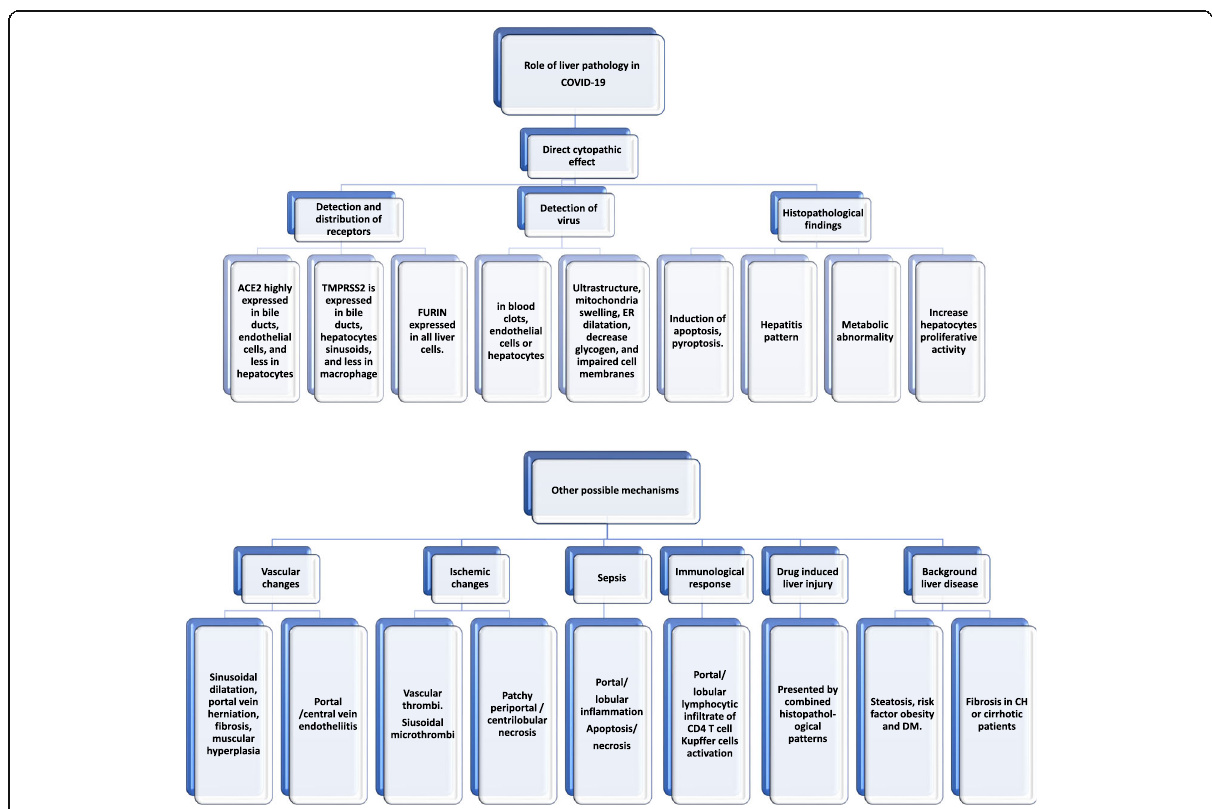
Fig. 5 The role of pathology in understanding SARS-CoV-2-induced liver injury mechanism. ACE2, angiotensin-converting enzyme-2; TMPRSS2, transmembrane protease, serine